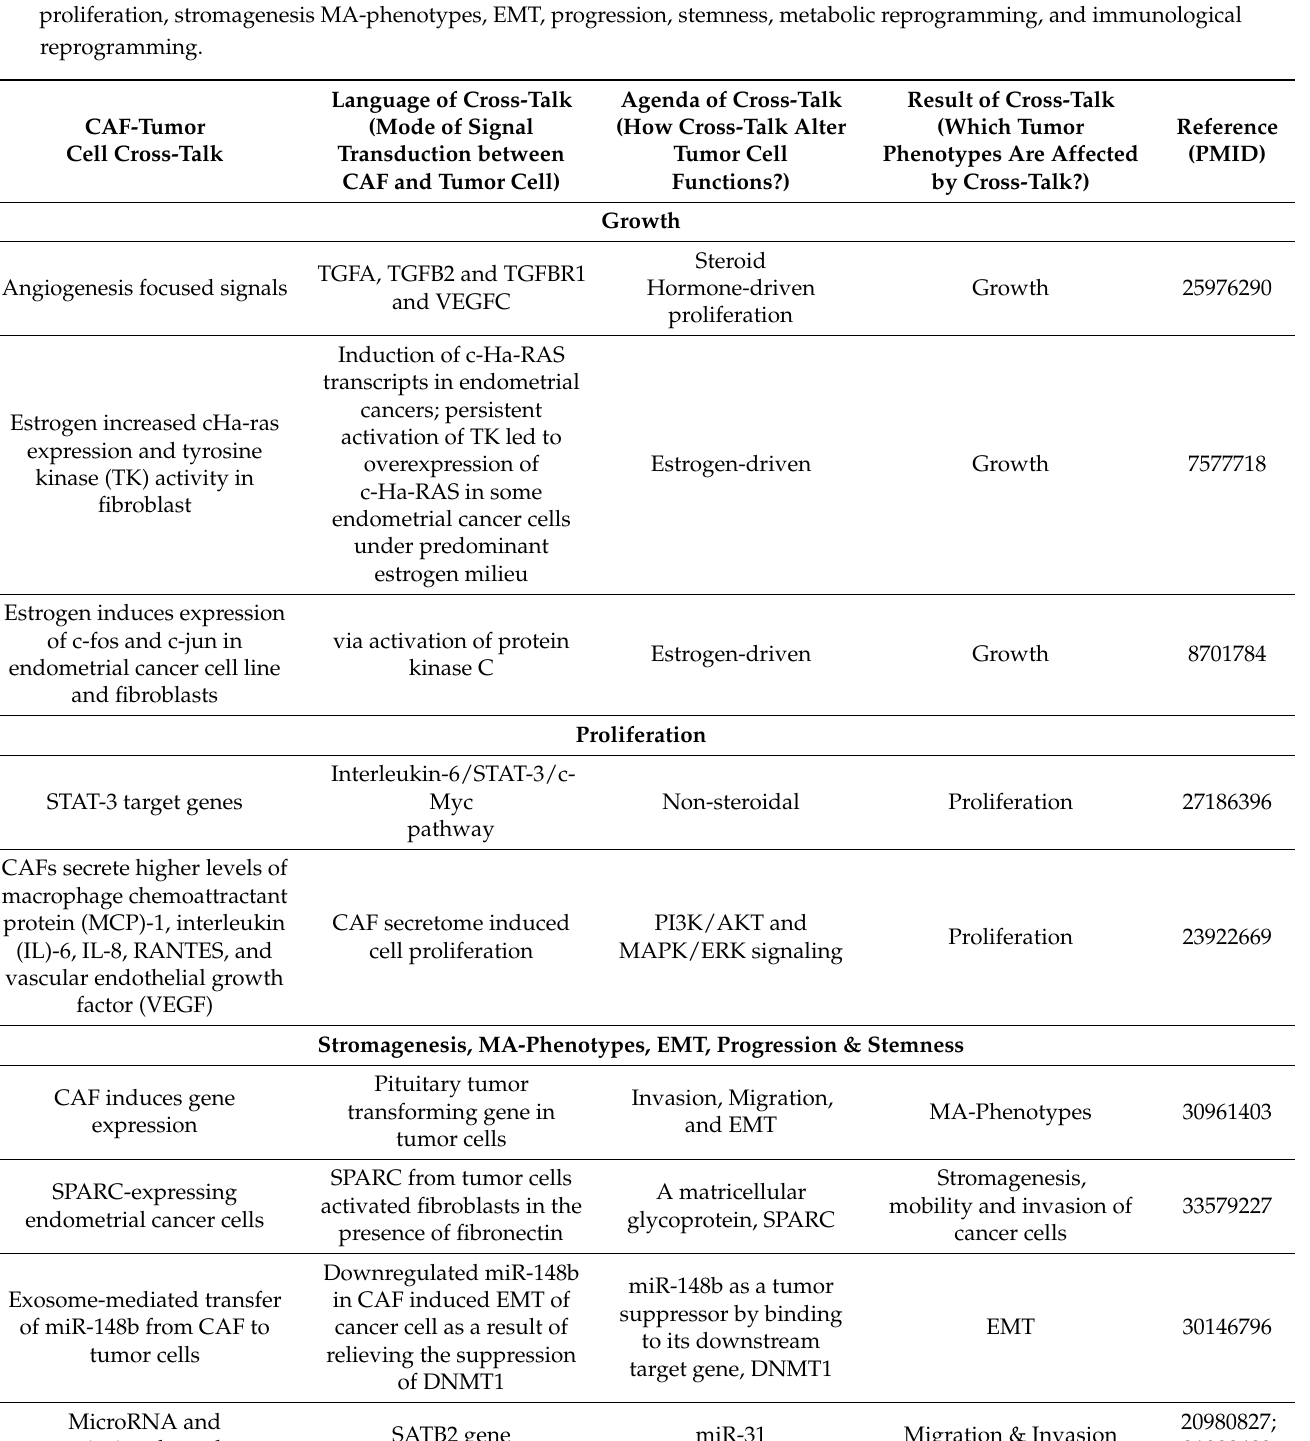
Table 1. The table presents CAF-Tumor cell cross-talk in endometrial cancers with specific reference to the language and the topic of the cross-talk. The information has been categorized according to the outcome of the cross-talk, including growth, proliferation, stromagenesis MA-phenotypes, EMT, progression, stemness, metabolic reprogramming, and immunological